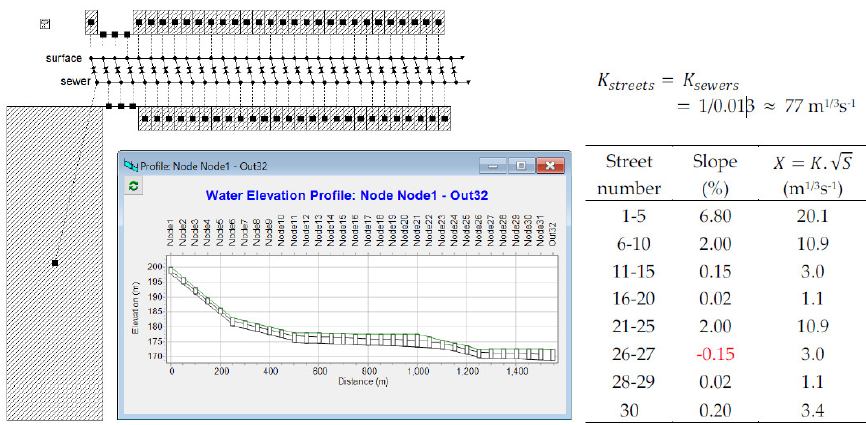
Figure 5. Map and longitudinal profile of the dual drainage system.